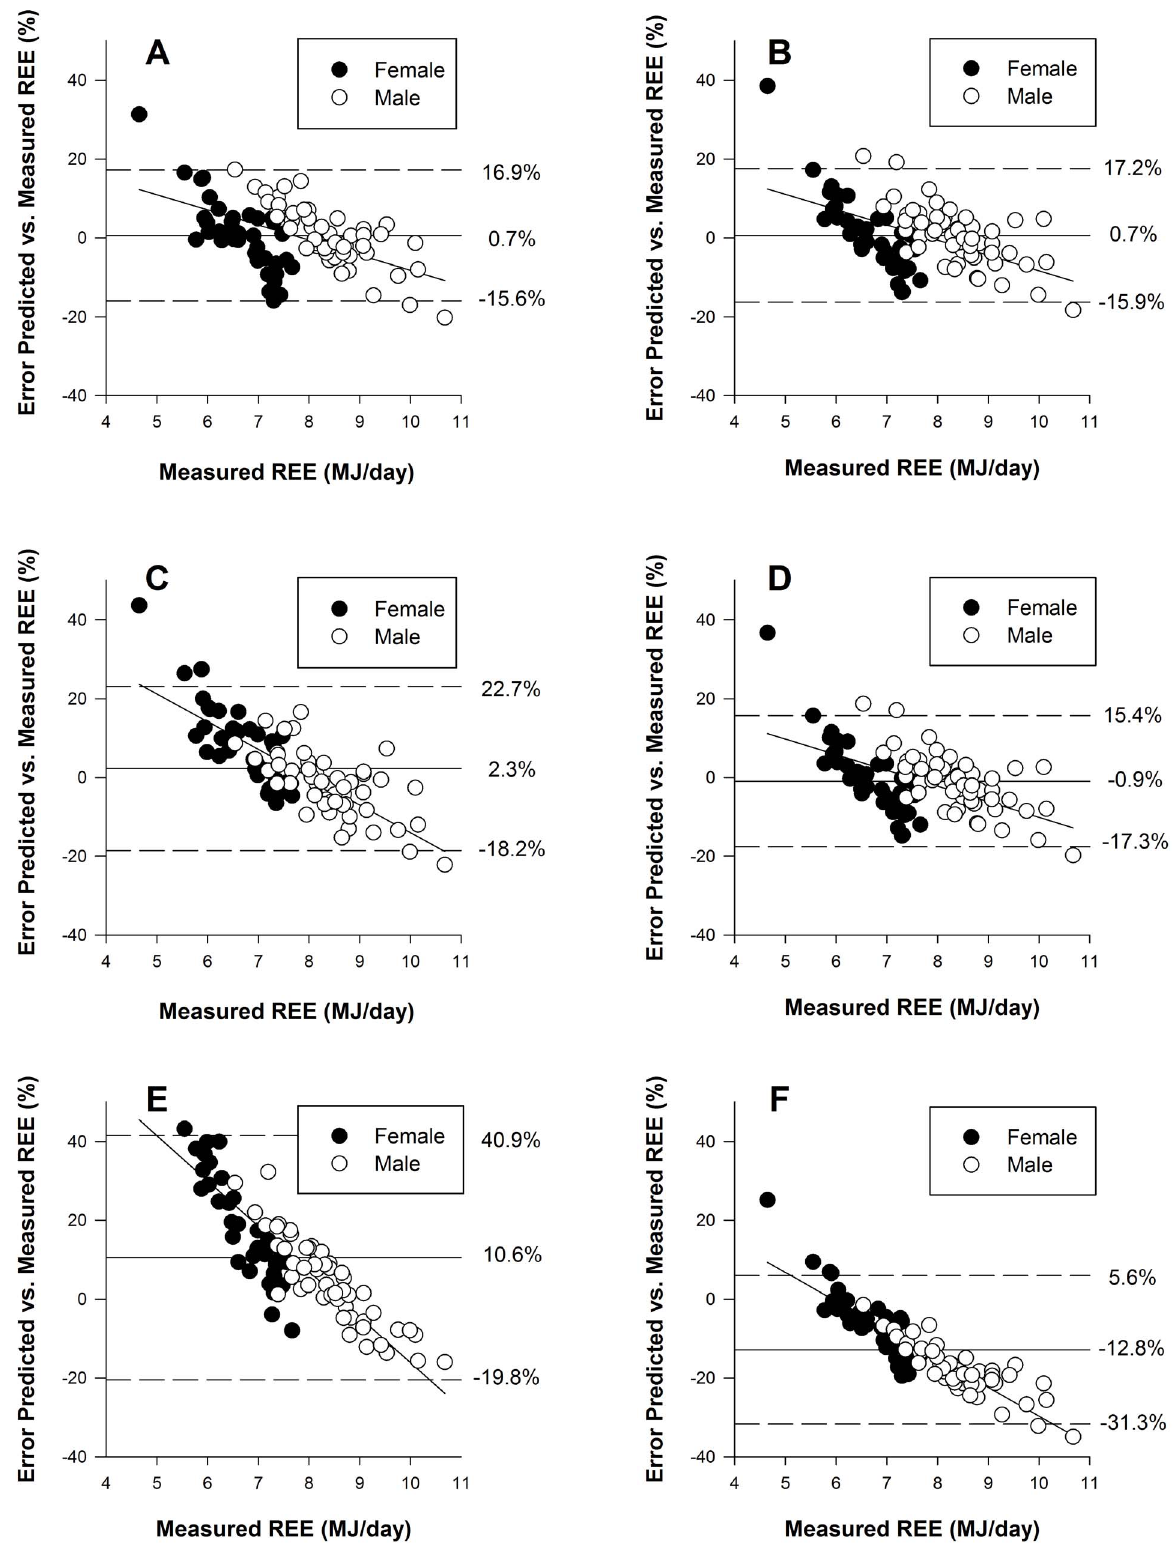
Figure 4. Limits of agreement analysis (bias: vertical solid line; 95% confidence interval: vertical dashed lines) for REE predictive equations versus measured REE (MJ/day) for male (open dot) and female (filled dot). Graphs represent equations of ( A ) new weight- based; ( B ) new FFM-based; ( C ) De Lorenzo; ( D ) Cunningham; ( E ) Owen FFM and ( F ) Harris-Benedict 1984.